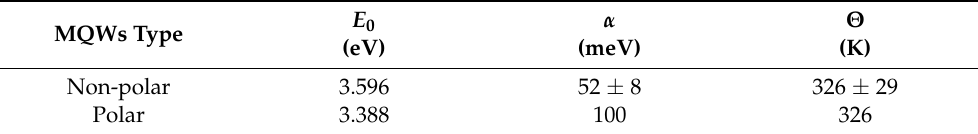
Figure 6. Temperature dependence of the PL peak energies of ( a ) non-polar and ( b ) polar GaN/Al 0.26 Ga 0.74 N (3 nm/22.5 nm) MQW structures. Dashed lines are fits to Equation (1) with the parameters listed in Table 2. Table 2. Simulation parameters of the Bose–Einstein expression for the temperature dependence of PL peak energies of non-polar and polar MQWs.